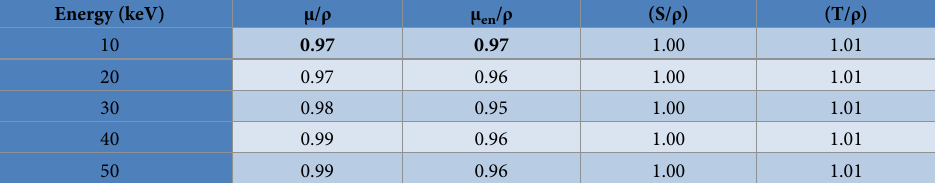
Table 1. Ratios between the electron and photon characteristic quantities (mass attenuation coefficient μ / ρ , mass energy-absorption coefficient μ en / ρ , mass stopping power S/ ρ and mass scattering power T/ ρ ) of the ferrous gel versus the soft tissue reference for energies between 10keV and